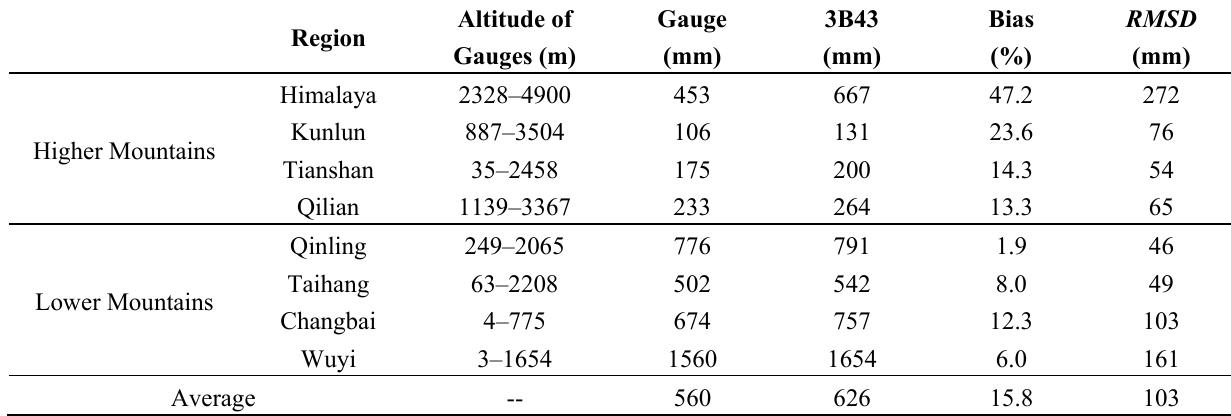
Table 2. Comparison of mean annual rainfall (2001–2012) from gauge measurements and the original